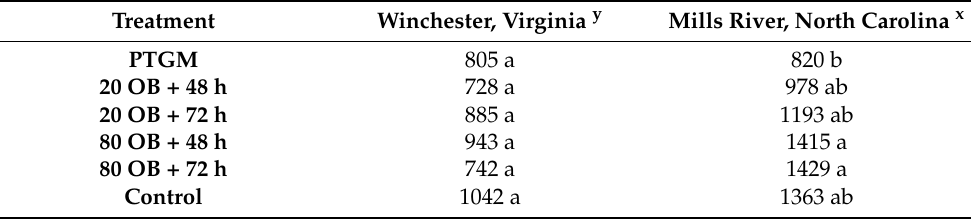
Table 4. Treatment effect on estimated yield (bushels/acre) of ‘Gala’ apples. z